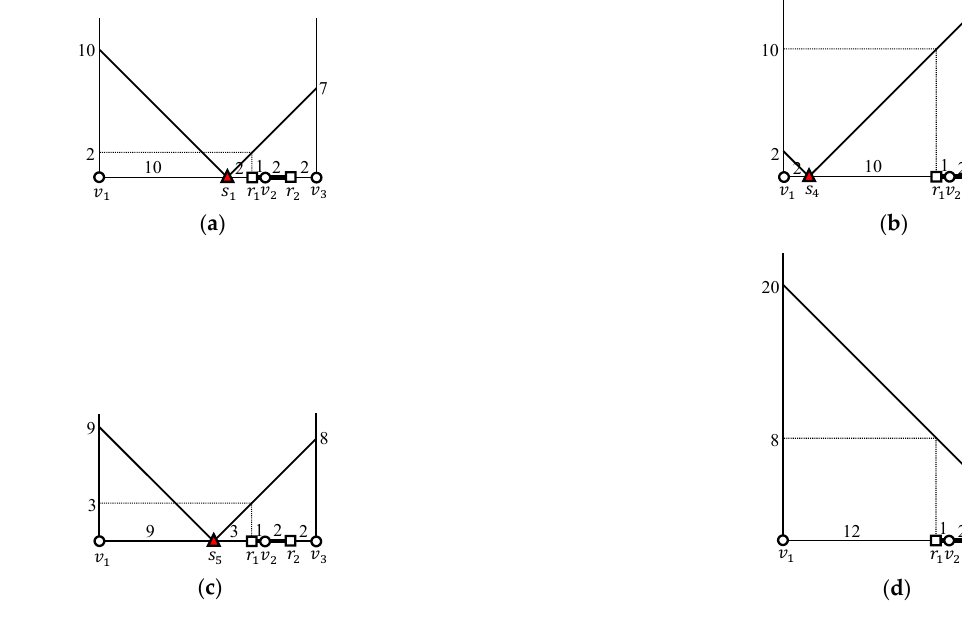
Figure 10. Computation of the distance from r 1 to s ∈ { s 1 , s 4 , s 5 , s 6 } ( a ) dist ( r 1 , s 1 ) = 2; ( b ) dist ( r 1 , s 4 ) = 10; ( c ) dist ( r 1 , s 5 ) = 3; ( d ) dist ( r 1 , s 6 ) =